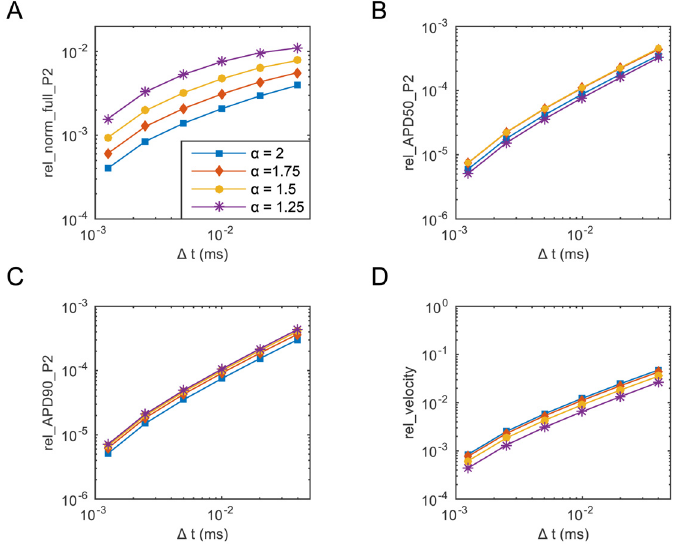
Fig 2. The four relative metrics as a function of the key parameter Δ t (the time step), for four selected values of α . The solution is computed for all values of α on the time interval [0,500 ms] with N = 400. All relative errors are evaluated by comparing the solution for a specific combination of α and Δ t with the solution obtained for the same α when Δ t = 6.25 (cid:3) 10 − 4 ms. In all simulations, the stimulus I stim = 40 μ A (cid:3) cm − 3 was applied on [0,0.05 cm] at t stim = 10 ms for two consecutive milliseconds and then